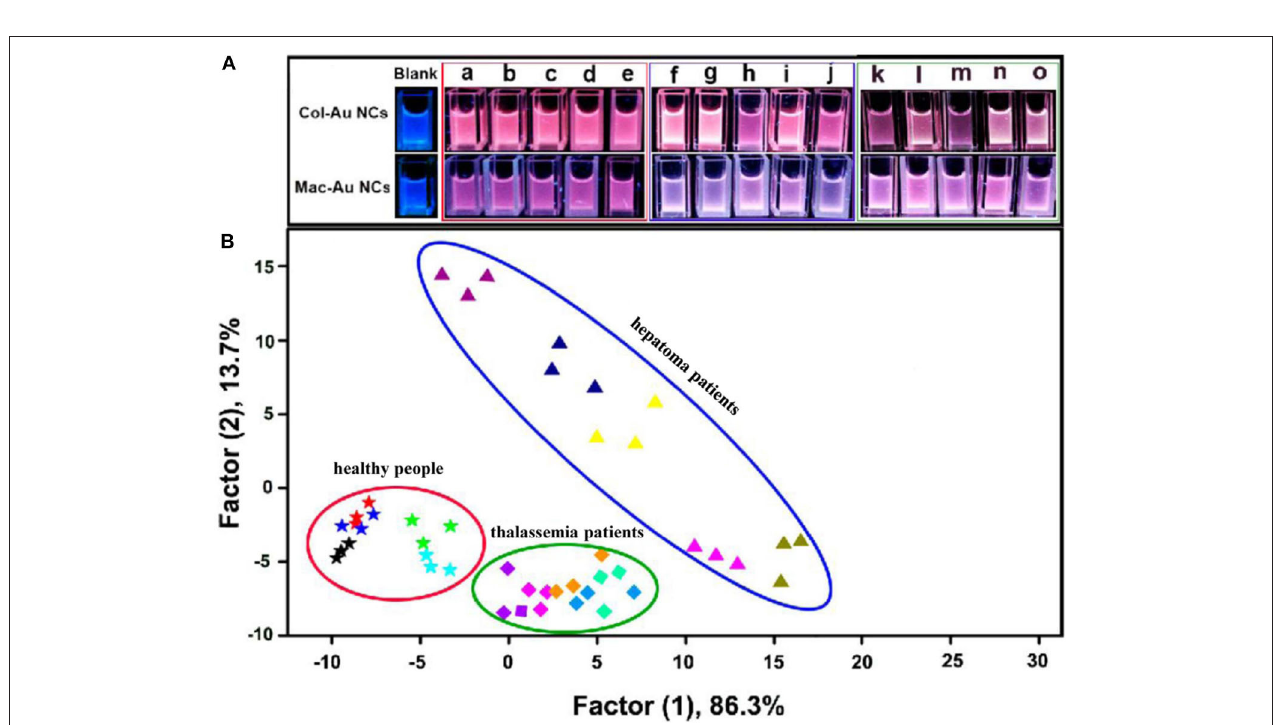
six different proteins, various concentrated proteins, protein mixtures and even samples in serum and urine. Later, they also used this type of sensor array to distinguish 4 different cell lines (Yang X. et al., 2014). In this type of sensor arrays, the addition of proteins can change the aggregation behaviors of DNA-AuNPs,